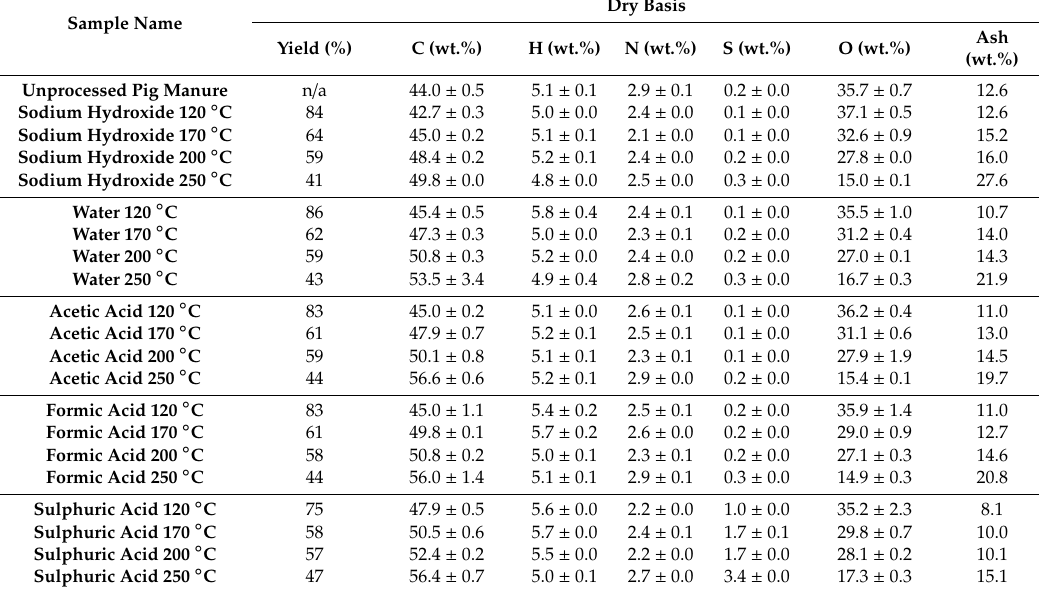
Table 2. Ultimate analysis and yields of fuels on a dry basis; n / a—not